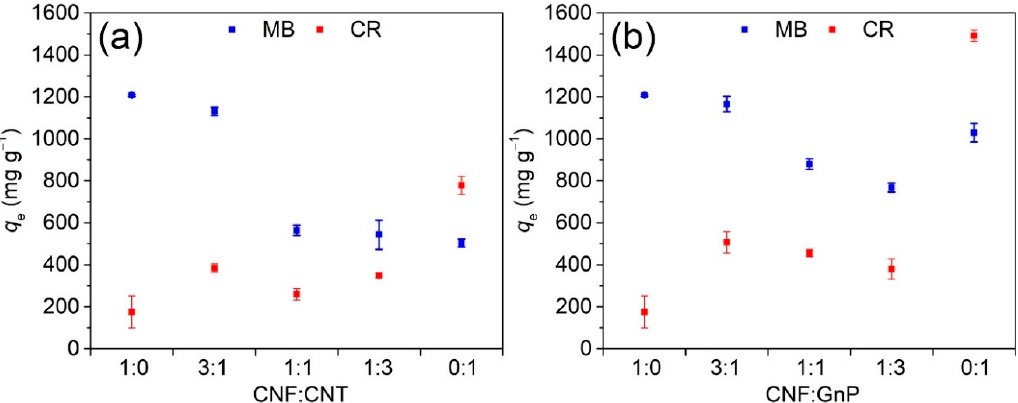
Figure 1. The final adsorption of MB and CR onto CNF–CNT aerogels with the mass ratio of 1:0, 3:1,